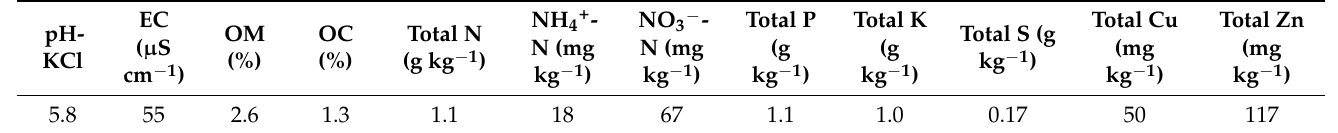
Table 1. Physicochemical characterization of air-dried